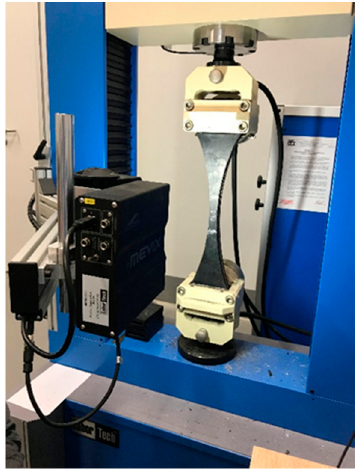
Figure 10. The LabTest 6.100 testing